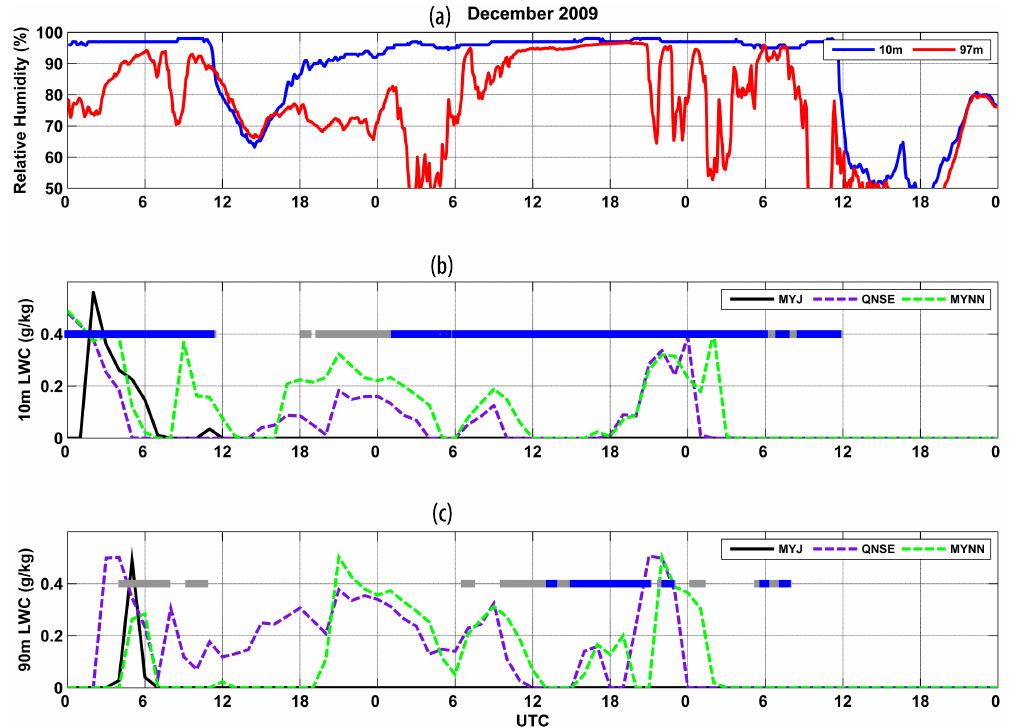
Figure 2. Analysis for 10, 11 and 12 December 2009. (a) Observed relative humidity at 10m (blue line) and 97m (red line). (b) Simulated LWC at 10m using MYJ (black line), QNSE (dashed purple line) and MYNN (dashed green line). Blue and grey rectangles indicate observed relative humidity at 10m larger than 95% and larger than 90% respectively. (c) Same as (b) for 90m. Blue and grey rectangles indicate the same as in (b) but for